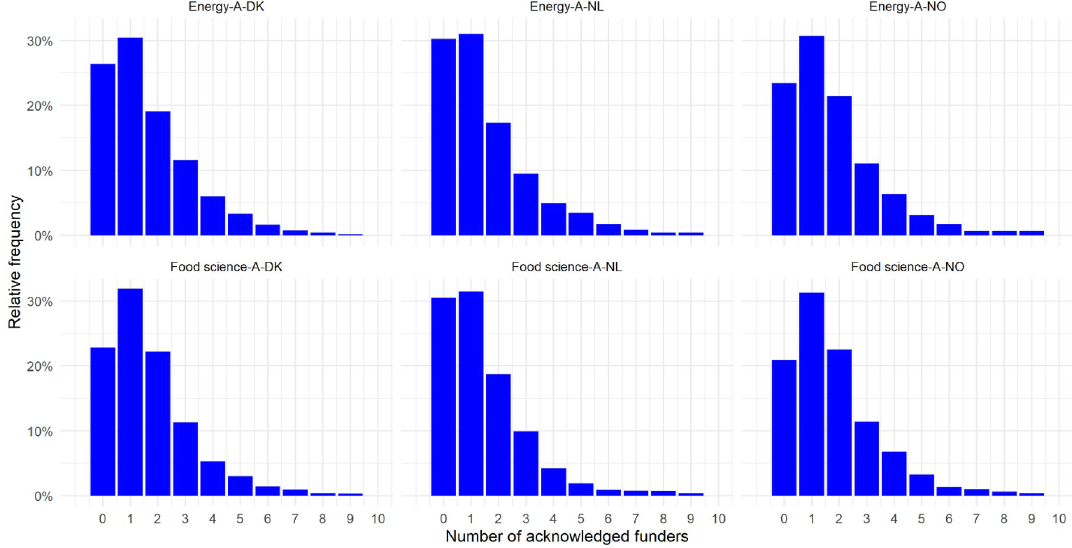
Fig 2. Frequency distributions of numbers of FAs across papers,